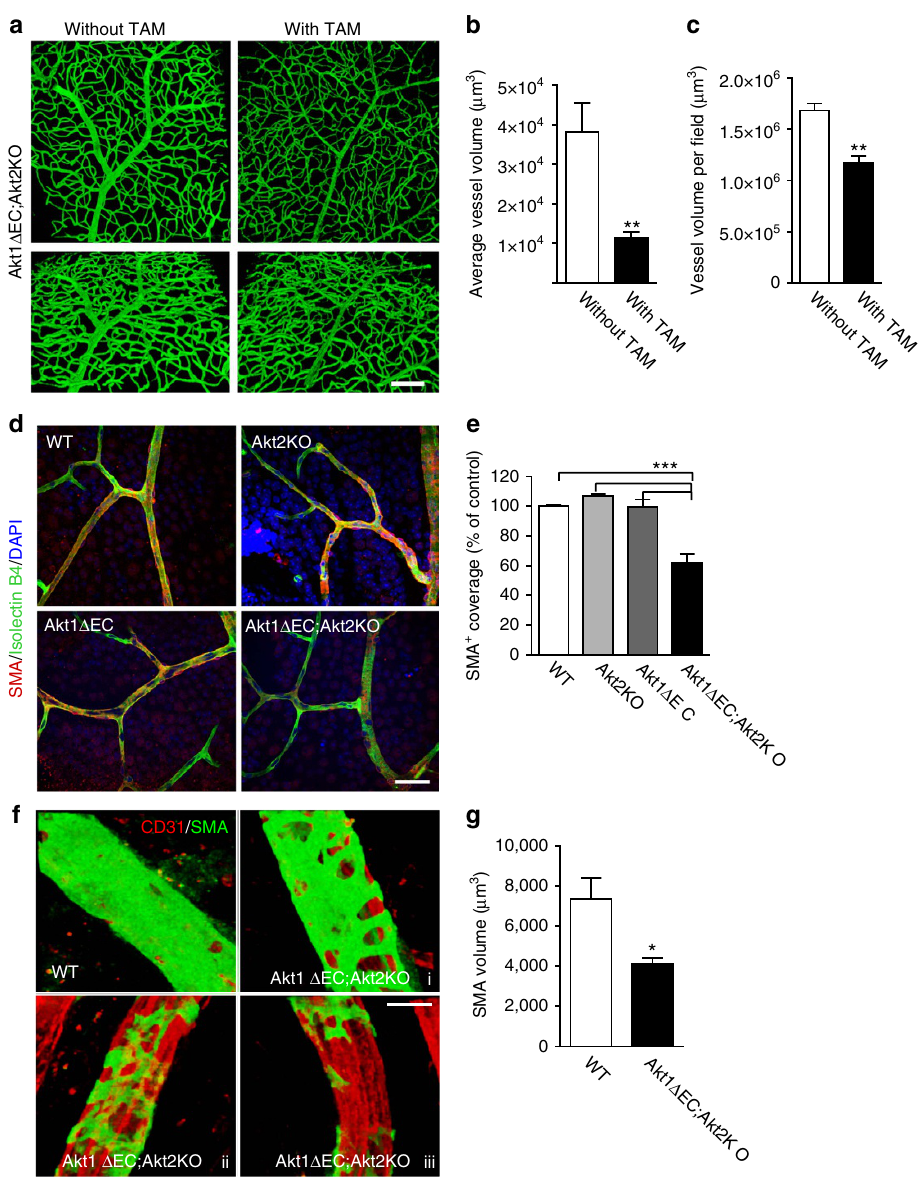
Figure 3 | Perfusion and regression of retinas after Akt1 deletion. ( a ) Representative images of Akt1 D EC;Akt2KO retinas of littermate mice (8–9 weeks of age) perfused with lectin with and without tamoxifen (TAM) treatment for 4 weeks. Scale bar, 100 m m. ( b , c ) Quantification of average vessel volume and vessel volume per field represented as mean ± s.e.m. ( n ¼ 3). ( d ) Representative images of WT, Akt2KO, Akt1 D EC and Akt1 D EC;Akt2KO whole-mount retinas after 4 weeks of tamoxifen treatment (8–9 week old mice) stained for SMA (red), isolectin B4 (green) and DAPI (blue). Scale bar, 50 m m. ( e ) Quantification of per cent SMA þ coverage represented as mean ± s.e.m. ( n ¼ 3). ( f ) Representative images of WTand three different Akt1 D